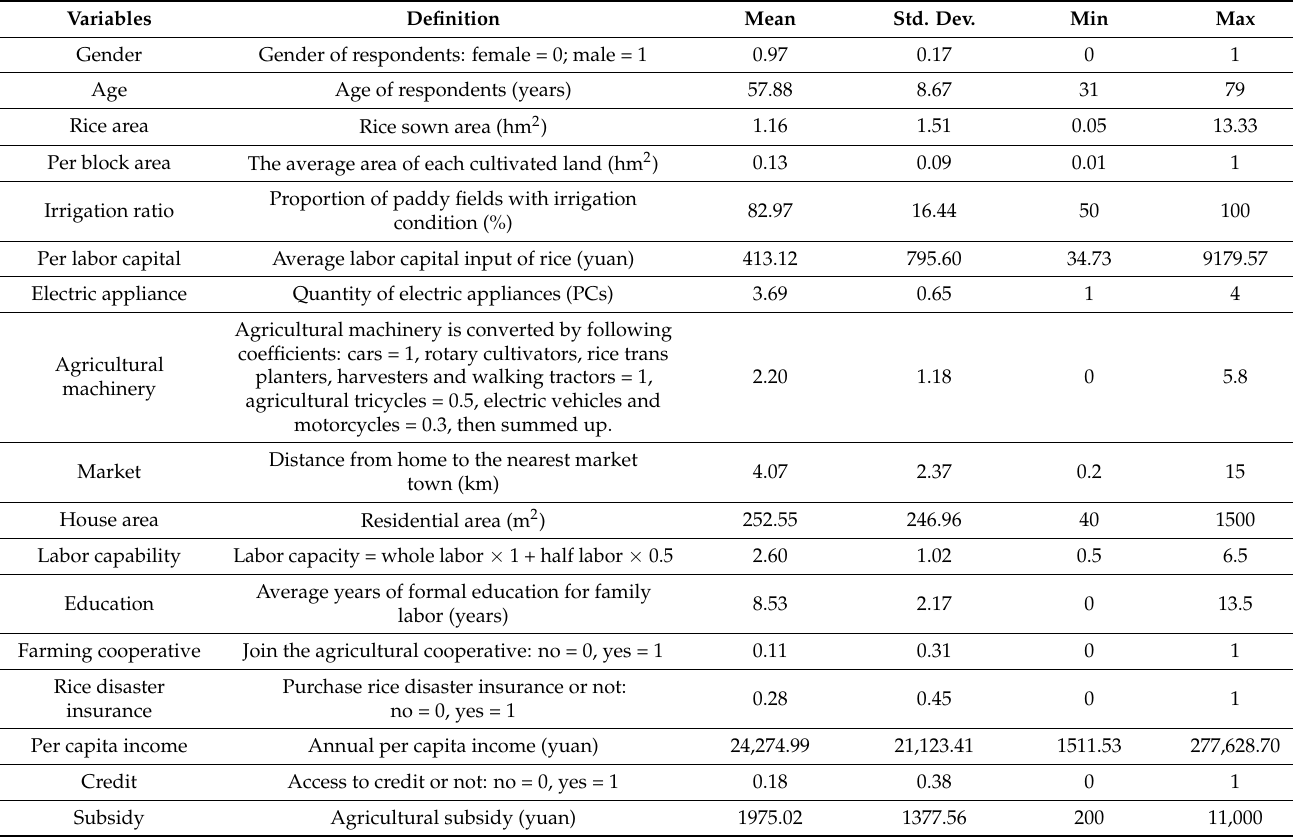
Table 1. The samples’ basic statistical characteristics.